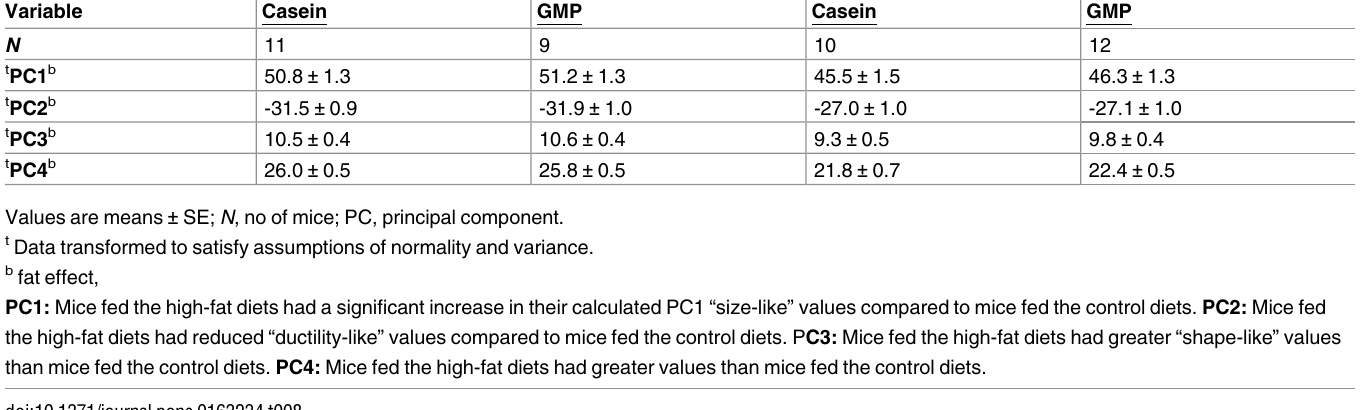
The summary of the regression analyses is consistent with the bone phenotype seen in the results of the biomechanical performance testing and the PCA, where the high-fat diets increase the strength of the bone, but makes it more brittle. The regression analysis gives insight into which indices of fat and fat-free mass have the greater impact on markers of bone status, including size, strength, and brittleness of the bone. Both fat-free mass and fat-mass are good predictors of bone size and mineralization, shown by a strong correlation between increased fat-free mass with increased cross-sectional area and BMD. The best marker to pre- dict bone strength, defined as maximum load a bone can tolerate before fracture, is total fat mass, including both visceral and subcutaneous fat weights. The brittleness of the bone is most strongly predicted by subcutaneous fat and visceral fat weights, which as their weight increases, the brittleness of the bone, measured as post-yield displacement, increases as well.